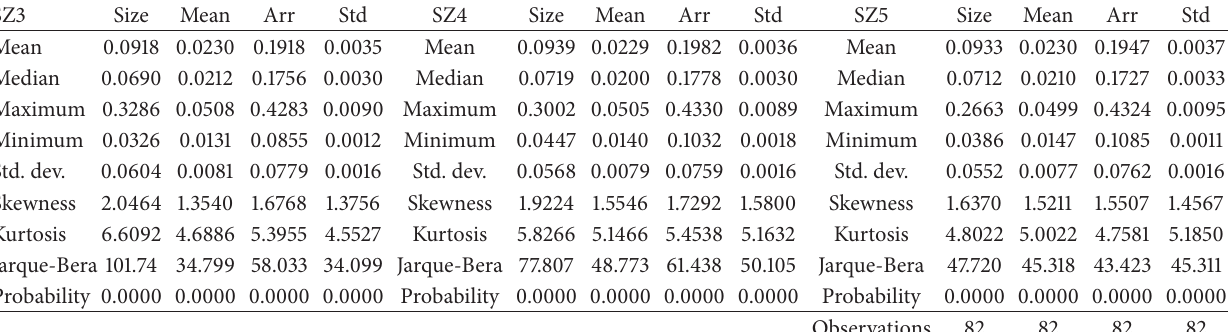
Table 13: Descriptive statistics of jump components for size 3 to size 5 portfolios.